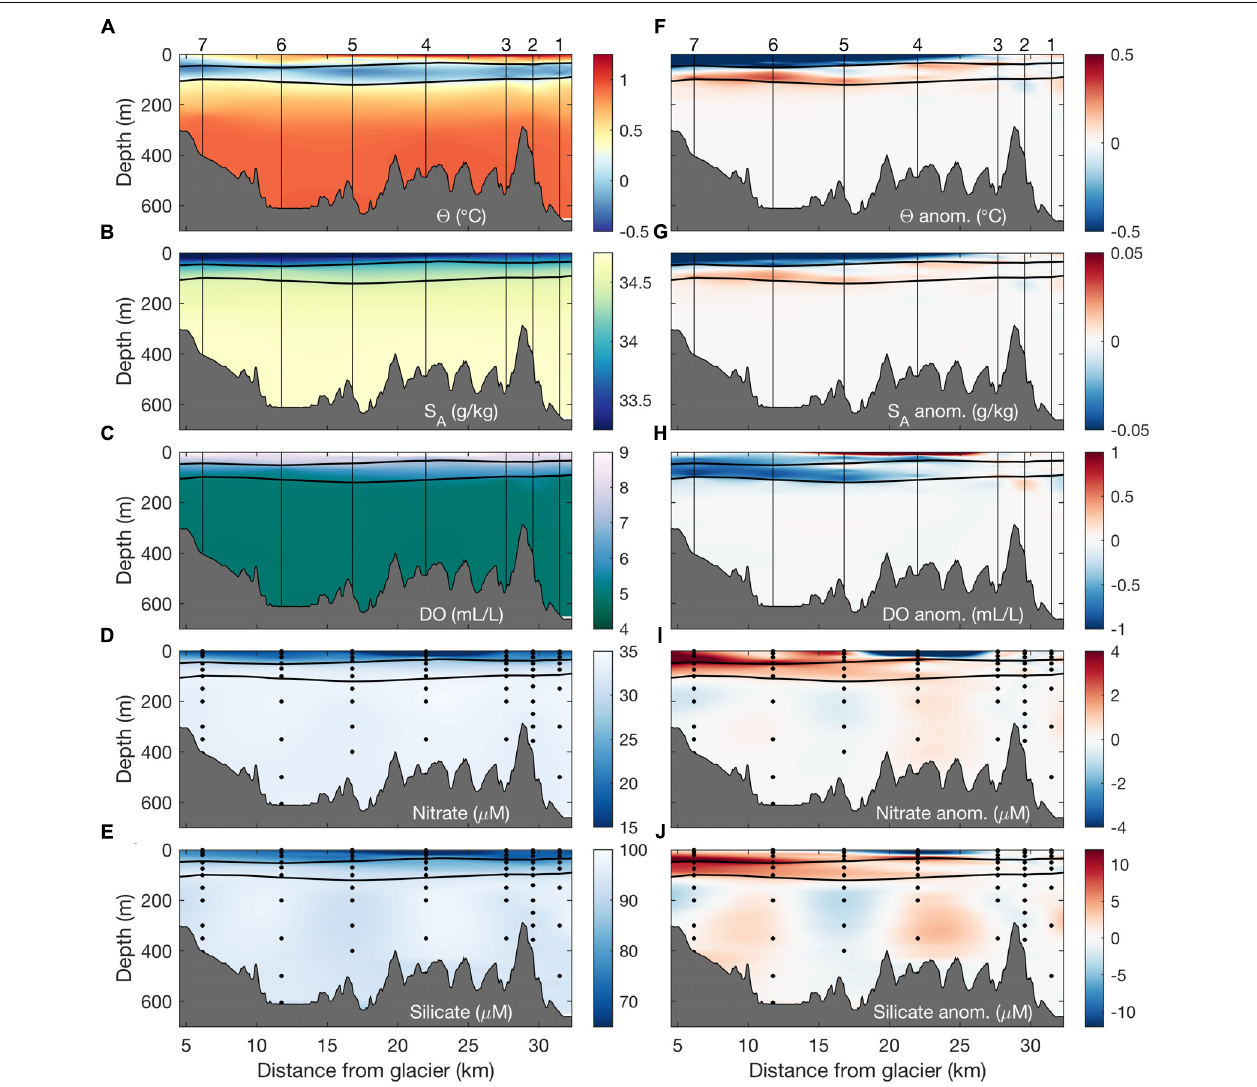
FIGURE 4 | Along-fjord sections of (A) temperature, (B) salinity, (C) dissolved oxygen, (D) nitrate, and (E) silicate for the section shown in Figure 1C . Panels (F–J) show along-isopycnal anomalies calculated relative to a composite reference profile (i.e., an average of profiles at stations 1–3). Vertical lines and points indicate locations of continuous hydrographic profiles and discrete water sample collection, respectively. Black horizontal lines correspond to the σ θ = 27.1 and 27.5 kg m − 3 isopycnals, approximately delimiting the winter water layer in Barilari